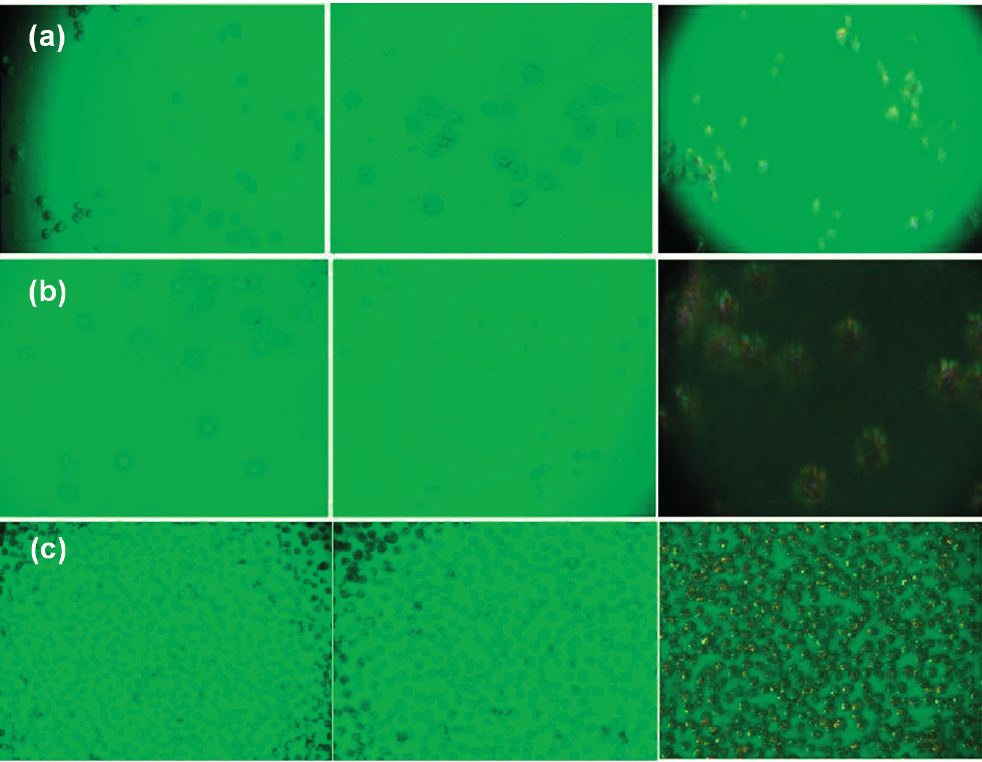
Figure 15. Light microscopy images of PC12 neuronal cells at ( a ) and ( b ) 3 days at 40× magnification and ( c ) 7 days at 25× magnification.